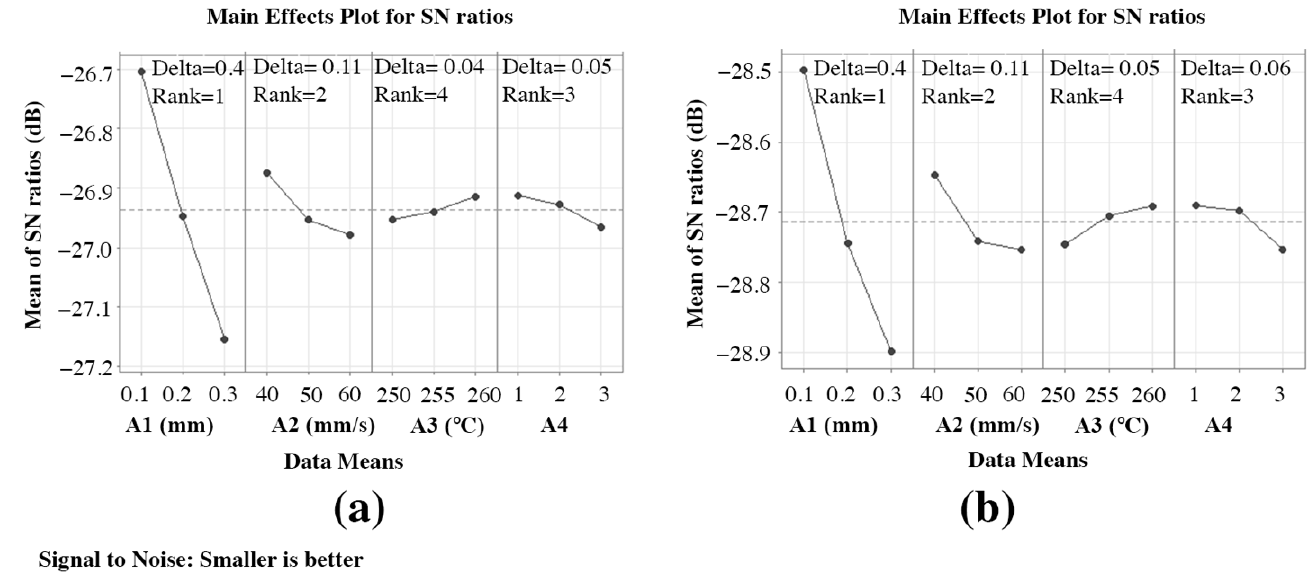
Figure 11. Mean S/N ratio for polymers: ( a ) Ra-ABS and ( b ) Rq-ABS.